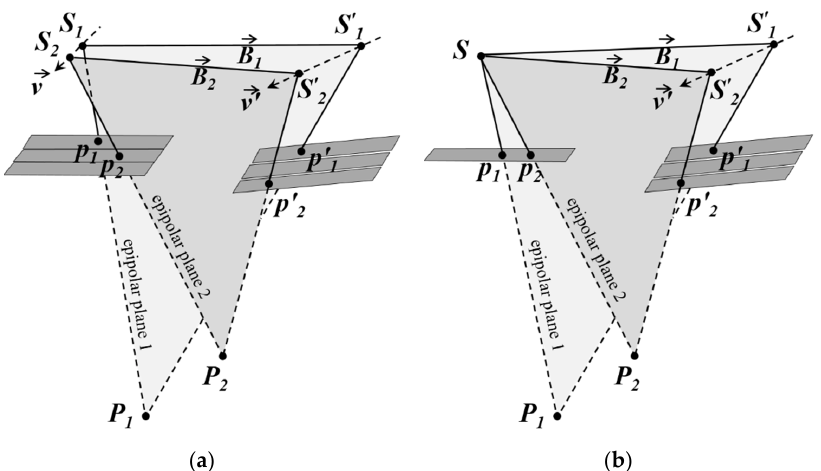
Figure 3. Variations in the direction of the IB of CIPs in the linear stereo scenes: ( a ) Temporal variations; ( b ) Spatial variations.